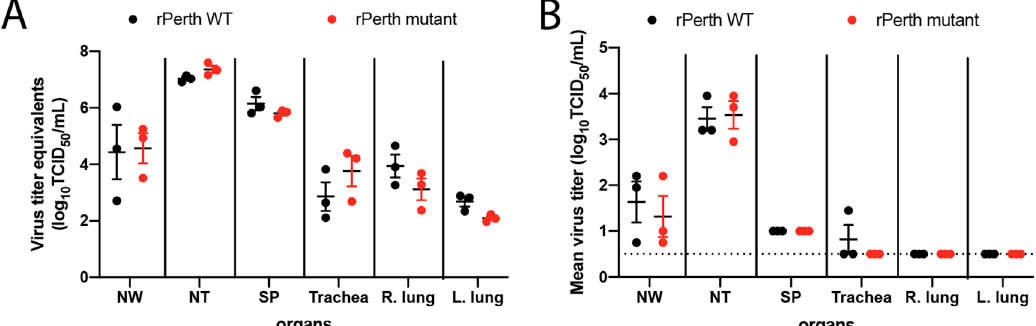
Figure 4. Quantification of H3N2 virus in respiratory tissues of infected ferrets. Ferrets were intranasally infected with 10 6 TCID 50 in 0.5 mL of rPerth WT (black circles) or rPerth mutant (red circles) and were sacrificed on day 3 post-infection. NW—nasal wash, NT—nasal turbinate, SP—soft palate. ( A ) RNA was isolated from the indicated respiratory tract organ homogenates and qPCR for a region of the M segment was performed to quantify the relative amounts of influenza virus, normalized to RNA isolated from a virus stock with a known titer. ( B ) Titration of tissue homogenates to quantify infectious viral titers. Each dot represents a single animal and mean line ±SEM is depicted.